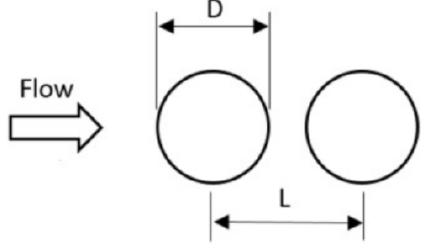
Figure 1. Flow over tandem